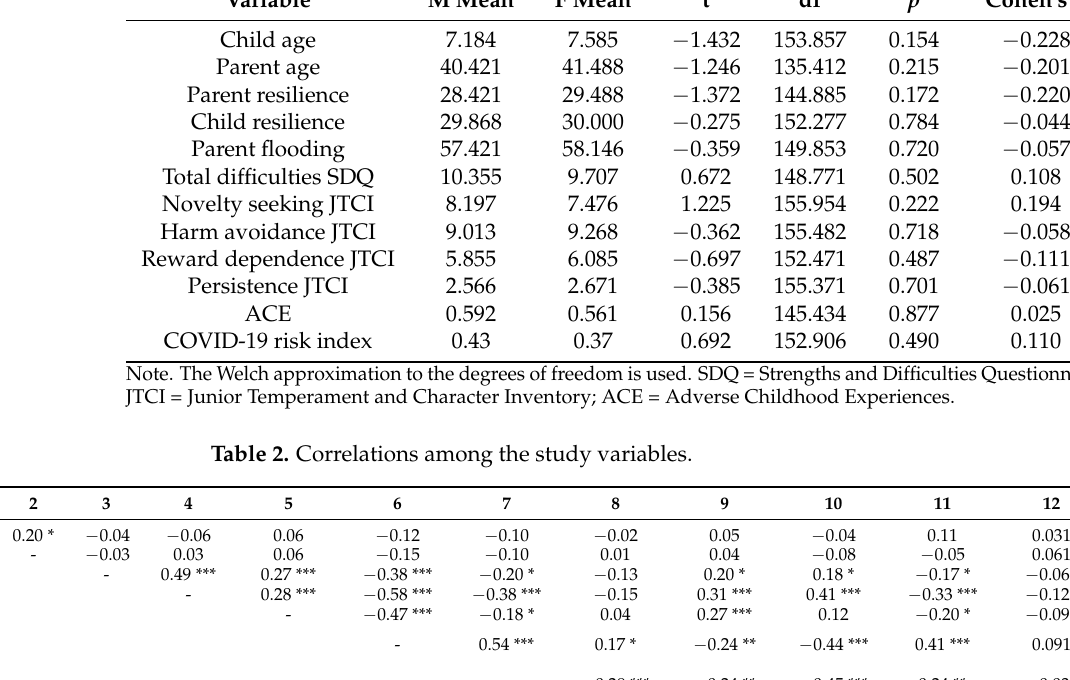
Table 1. Descriptive statistics and t -tests for gender differences in the study variables.